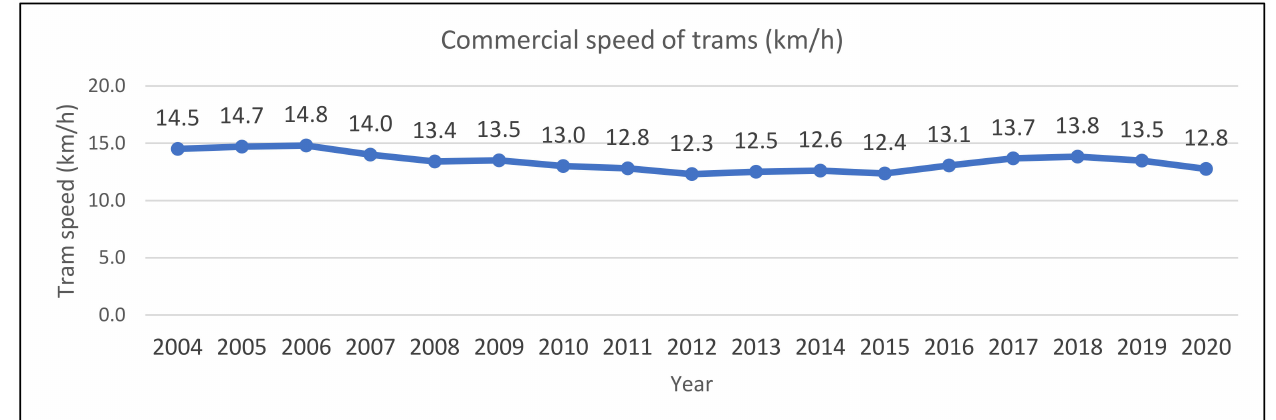
Figure 2. Commercial speed of tram lines in City of Zagreb